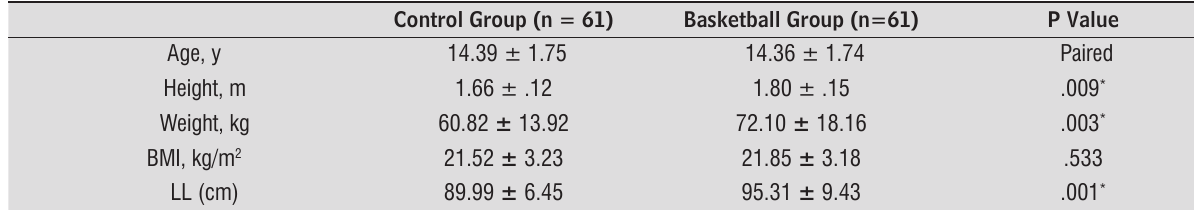
Table 1 - Participant characteristics